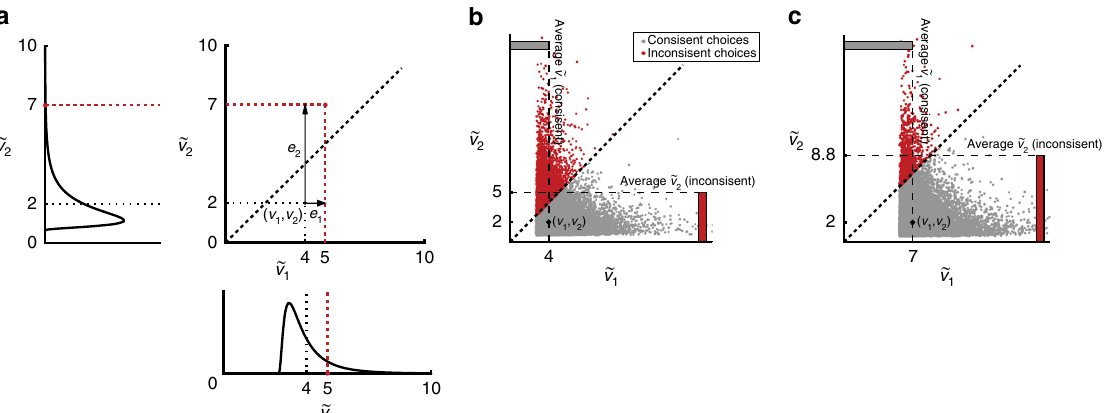
Fig. 6 The neural random utility model with two alternatives. a Inconsistent binary choice: A draw (red) of utilities from a log normal distribution with mean ~ v v = 4 and v = 2, (log s.d. = 0.7). In this draw, ~ v , so the inconsistent option (with lower mean valuation) is chosen. b Average random utility: A sample 1 2 2 > 1 of 2,000,000 utilities from the distribution in a . The average utility is higher when the inconsistent option is chosen. c Larger difference: A sample of utilities from distributions with a larger difference in mean valuations (log normal, means v 1 = 7 and v 2 = 2, (log s.d. = 0.7). The average utility of an inconsistent choice is larger when the choice is more inconsistent (the difference in mean valuations is larger compared to b )